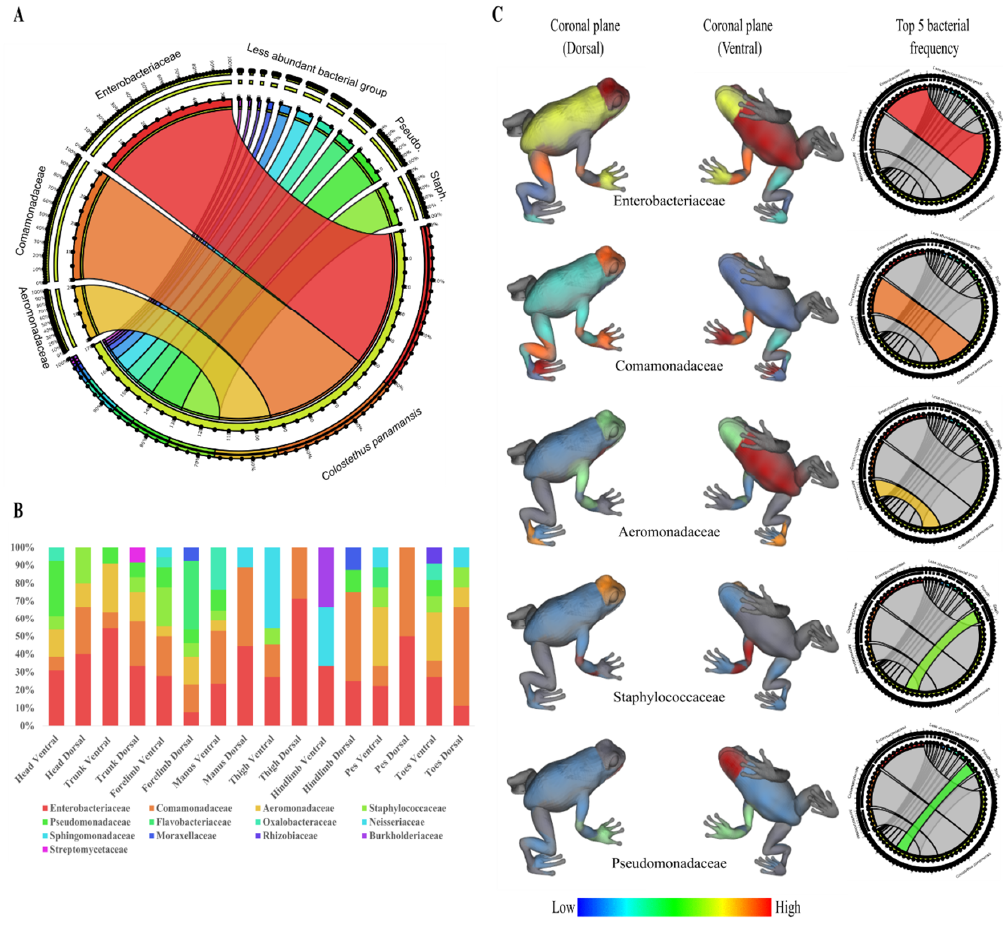
Figure 1. Frequency of isolated bacteria from the skin surface of C. panamansis . ( A ) Relative abundances of bacterial families from the skin of C. panamansis based on 16S rRNA amplicon sequencing. ( B ) The proportional abundance (as a percent of total sequences) of bacterial families based on body parts. ( C ) 3D topographic map of C. panamansis based on the five most abundant bacterial families isolated at each body location. Red represents the highest percentage of each family that was isolated and blue the lowest percentage.